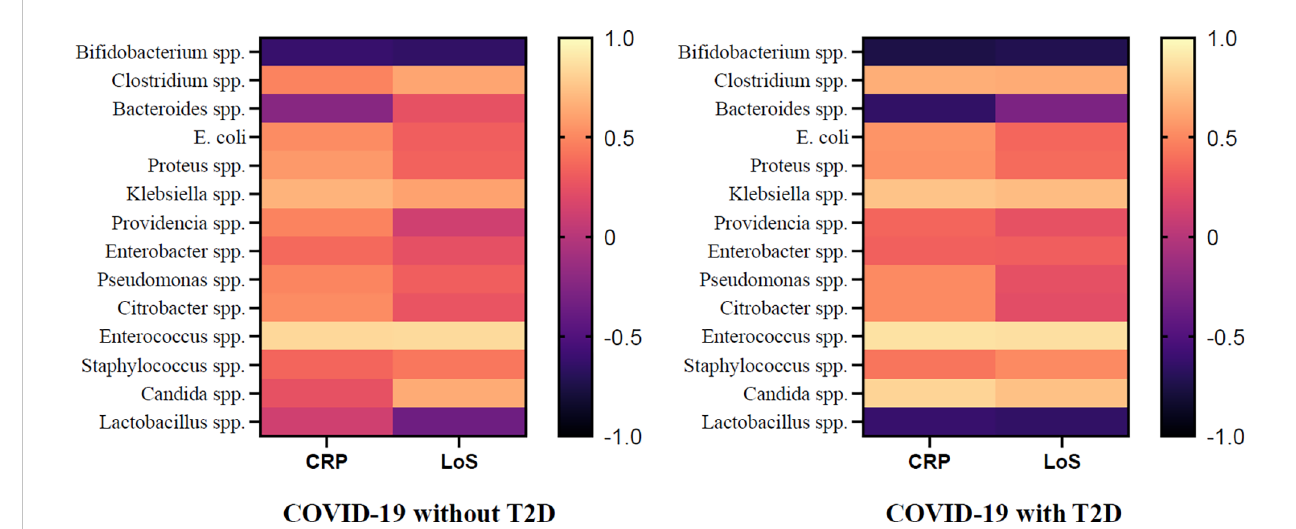
FIGURE 7 Association of CRP, LoS and Abundance of Gut Microorganisms in COVID-19 Patients with and without